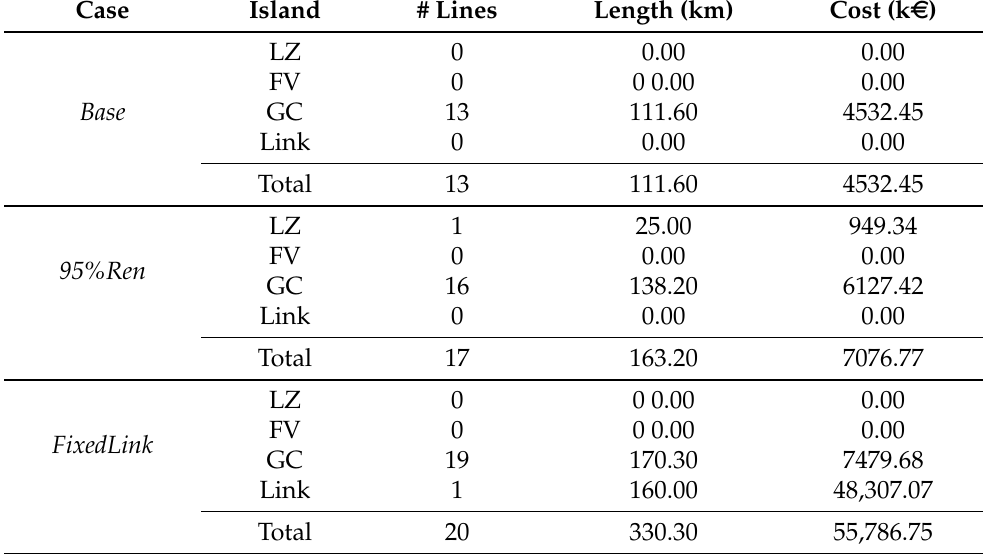
Table 13. Investments in transmission lines.